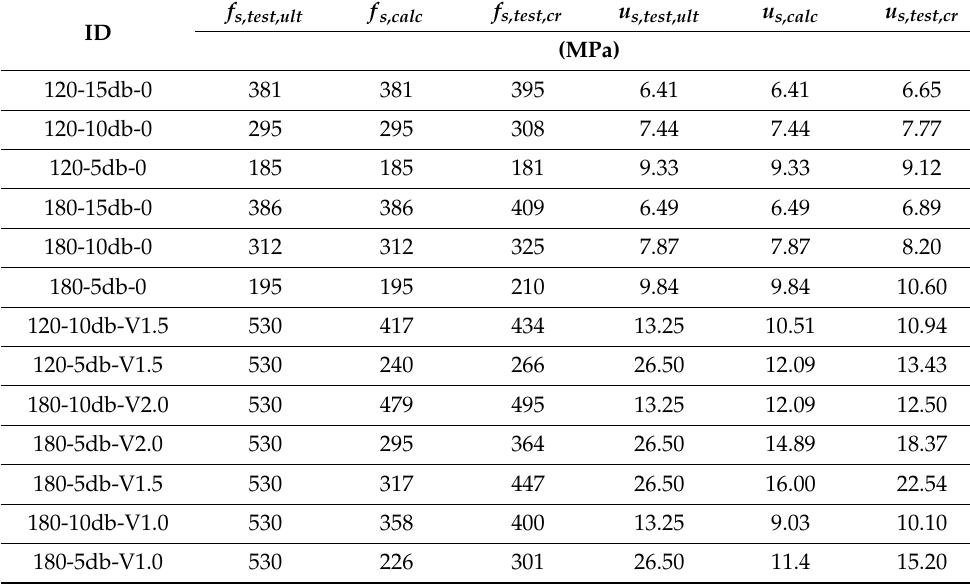
Table 5. Stress at lap-spliced region measured and calculated values. f s,test,ult f ID